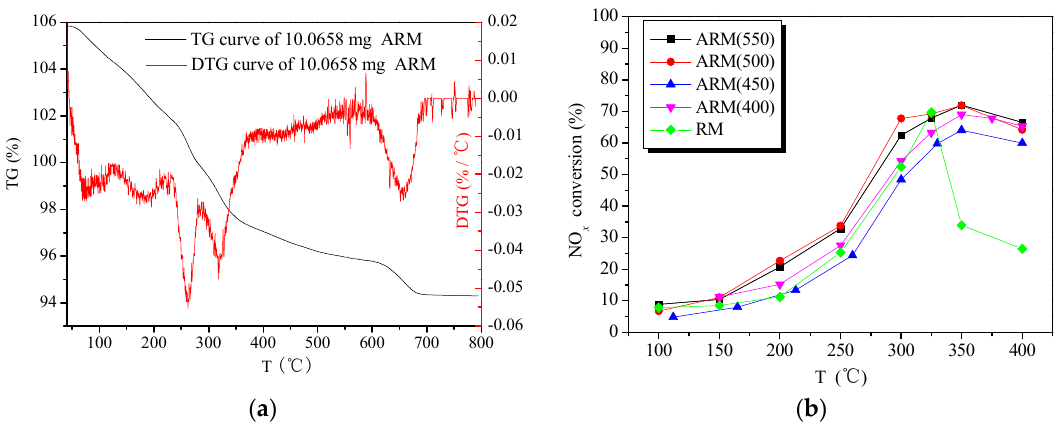
Figure 4. ( a ) The TG ‐ DTG curves of 10.0658 mg ARM; ( b ) catalytic activity of RM, ARM(400), ARM(450), ARM(500) and ARM(550). Reaction conditions: reaction gas pressure = 0.1 MPa, N 2 balance, total flow = 2000 mL ∙ min − 1 , GHSV = 30,000 h − 1 , [NH 3 /NO] = 1.0, initial concentration of NH 3 , NO and O 2 = 0.05%, 0.05% and >3.5%, respectively.